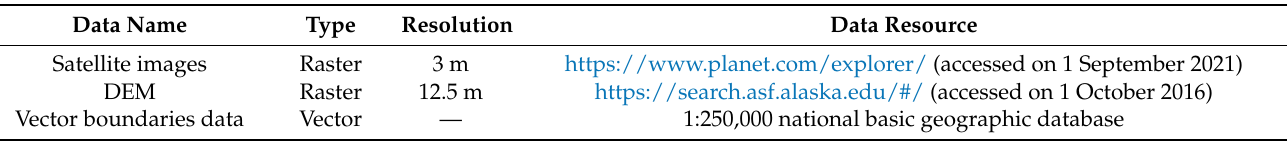
Table 1. Details of data used in this